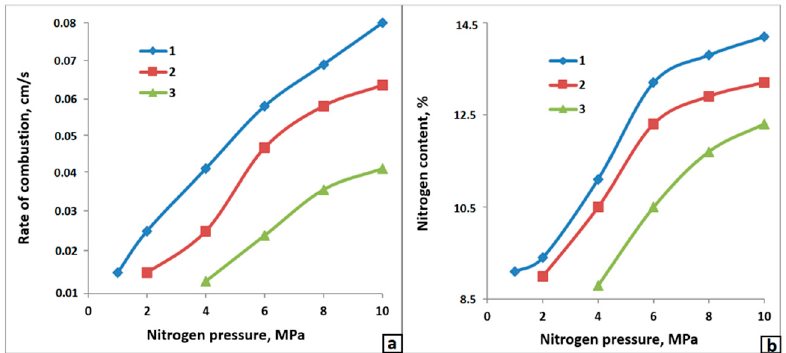
Figure 10. ( a ) Impact of nitrogen pressure on combustion rates, and ( b ) degree of nitridation of Fe-Cr. 1—0.02 mm, 2—0.04 mm, and 3—0.08 mm.